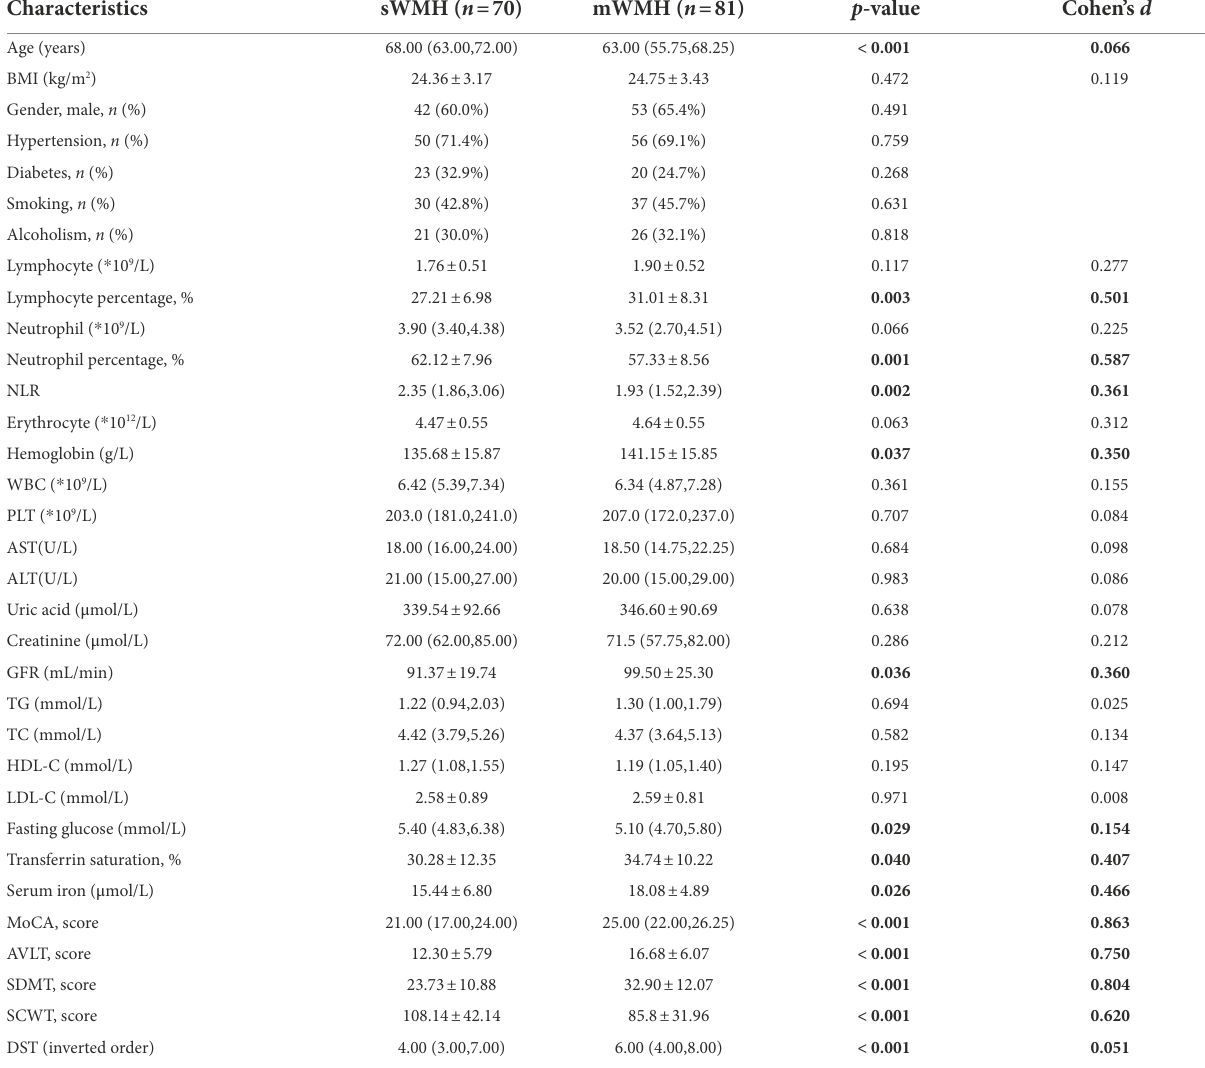
TABLE 3 Comparison of variables between the sWMH and mWMH groups.